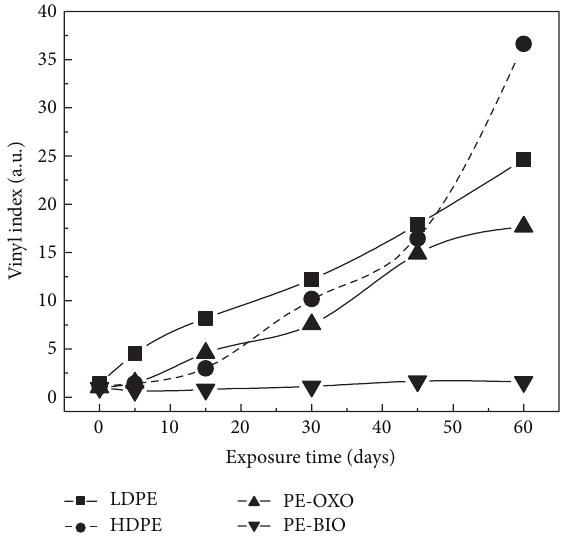
Figure 4: Crystalline phase fraction of LDPE ( ◼ ), HDPE ( 󳵳 ), PE- BIO ( 󳶃 ), and PE-OXO ( e ) films exposed to UV-B radiation.